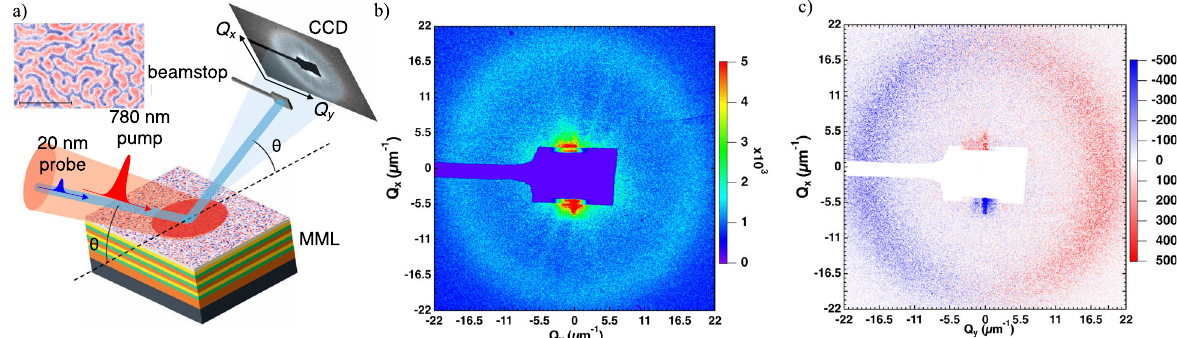
Fig. 1 CD-XRMS experiments at Co M edge. a Experimental con fi guration with the incident beams of the IR pump and the x-ray probe. Inset: MFM phase map displaying labyrinthine domains after out-of-plane demagnetization, scale bar is 2 µ m. b Magnetic diffraction pattern, (CL + CR). c Dichroic pattern (CL-CR), displaying the typical signature of clockwise Néel domain walls. The images in panels b , c have been geometrically corrected to account for the projection related to the photon incidence angle θ = 45°, and the scale corresponds to the sum of the counts (500 XFEL pulse of each polarization) for (CL + CR) ( b ) and (CL-CR) (